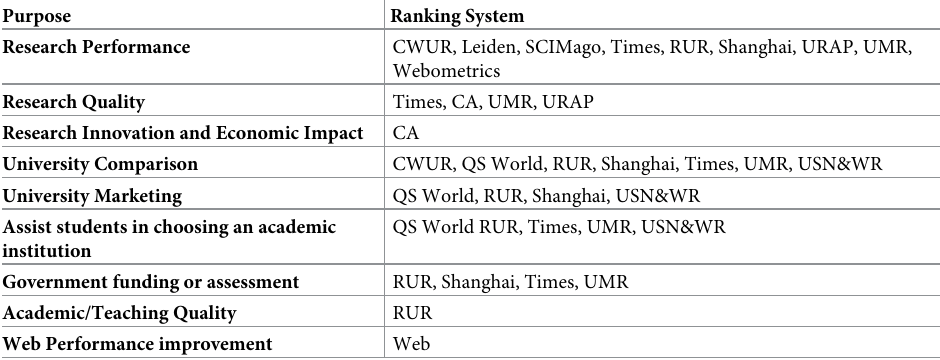
Table 2. Stated purpose and use of ranking